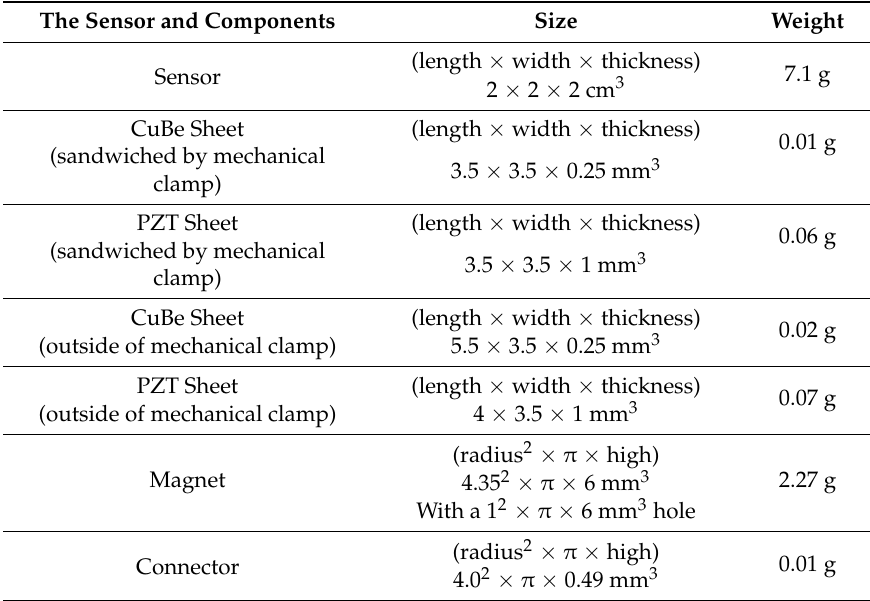
Figure 2. The photographs of the fabricated AC magnetic sensor: ( a ) top view and ( b ) isotropic view. Table 1. The dimensions of the AC magnetic sensor and its components.